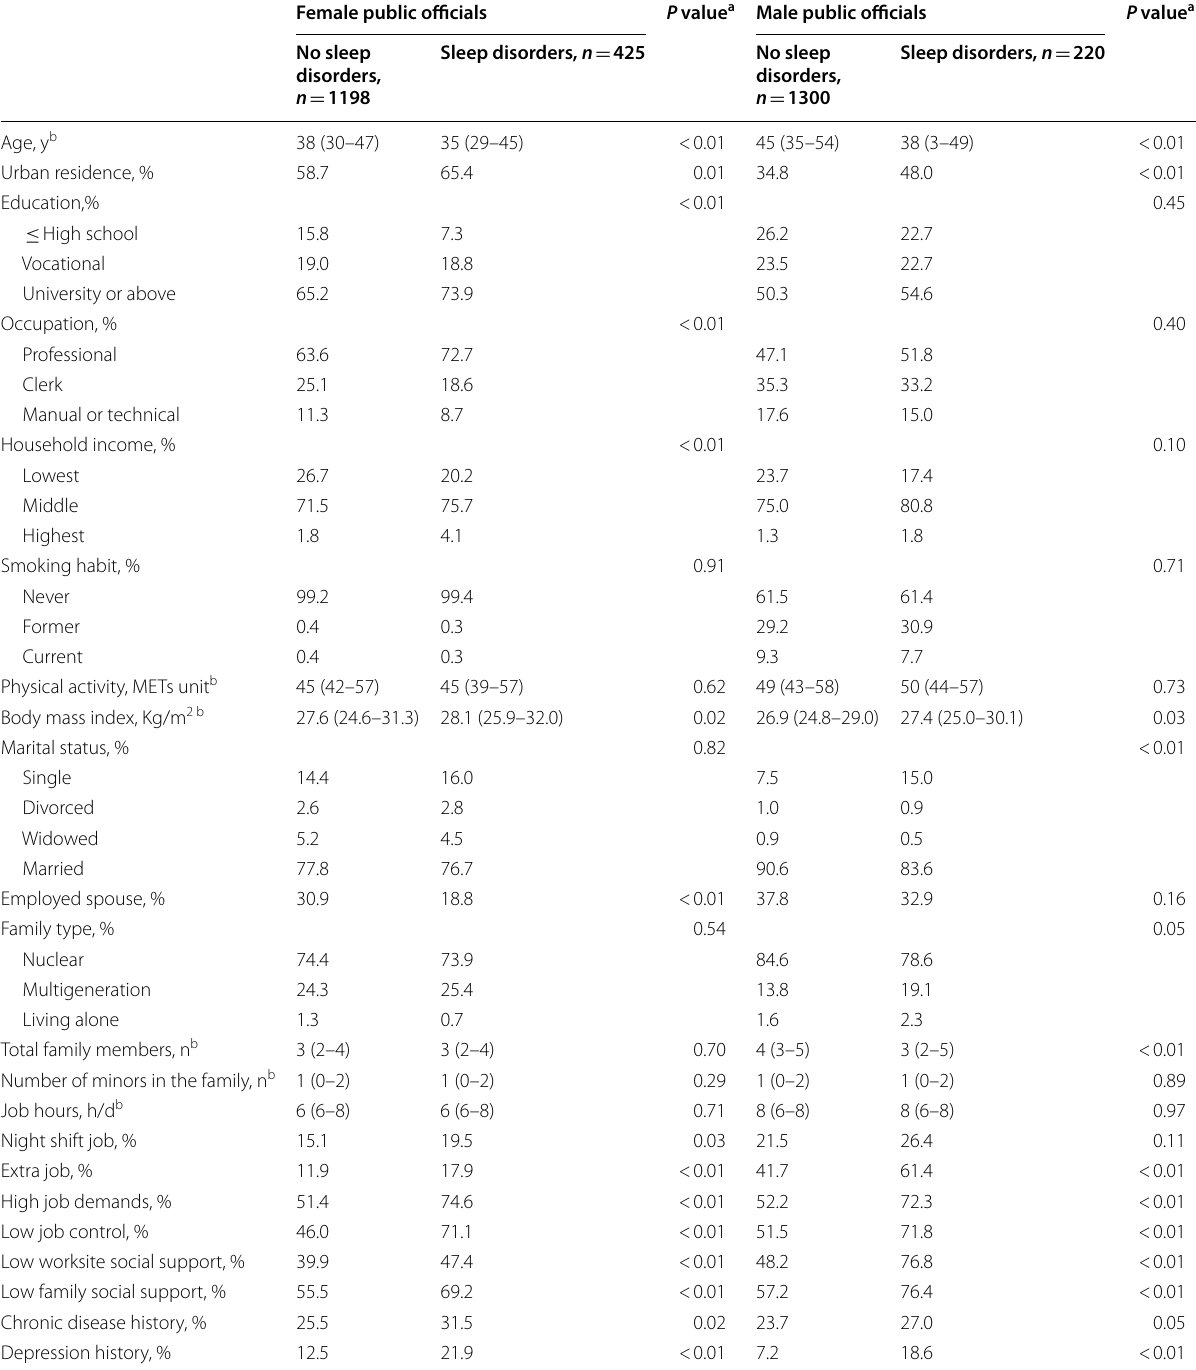
Table 1 Gender-specific participants’ characteristics according to the presence of sleep